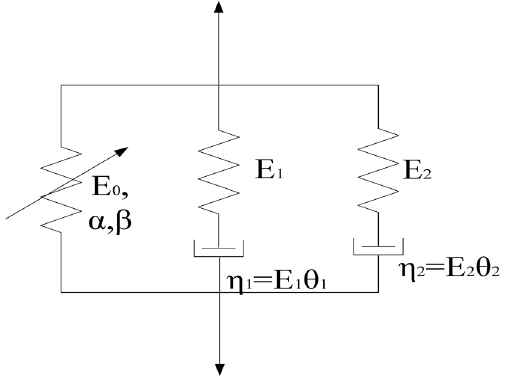
Figure 9. Rheological form of the ZWT model.